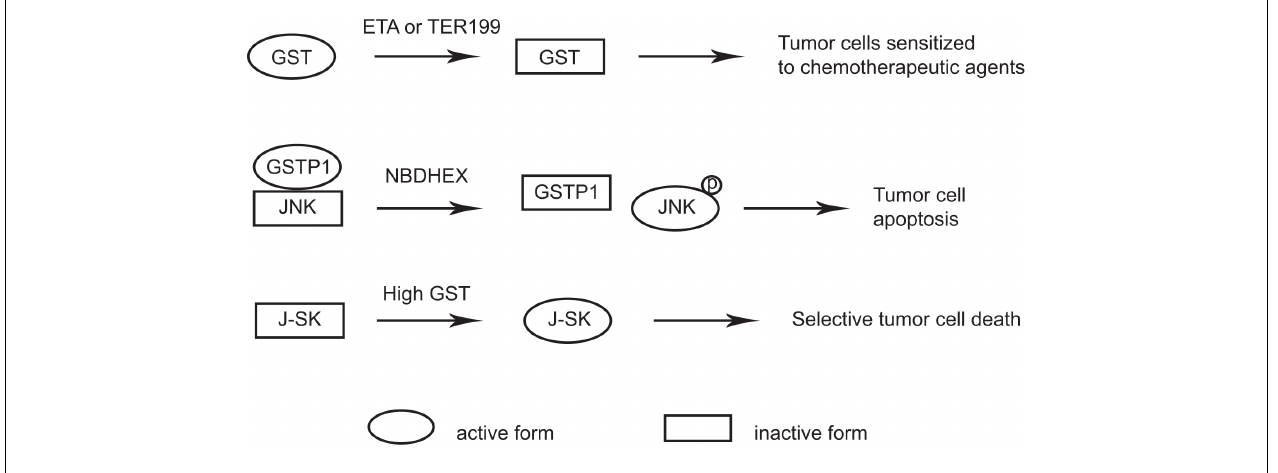
tumor cells interrupts GSTP1–JNK interaction which releases and activates JNK and results in tumor cell apoptosis. Prodrugs such as J-SK is activated specifically in tumors with high GST activity and selectively kills tumor